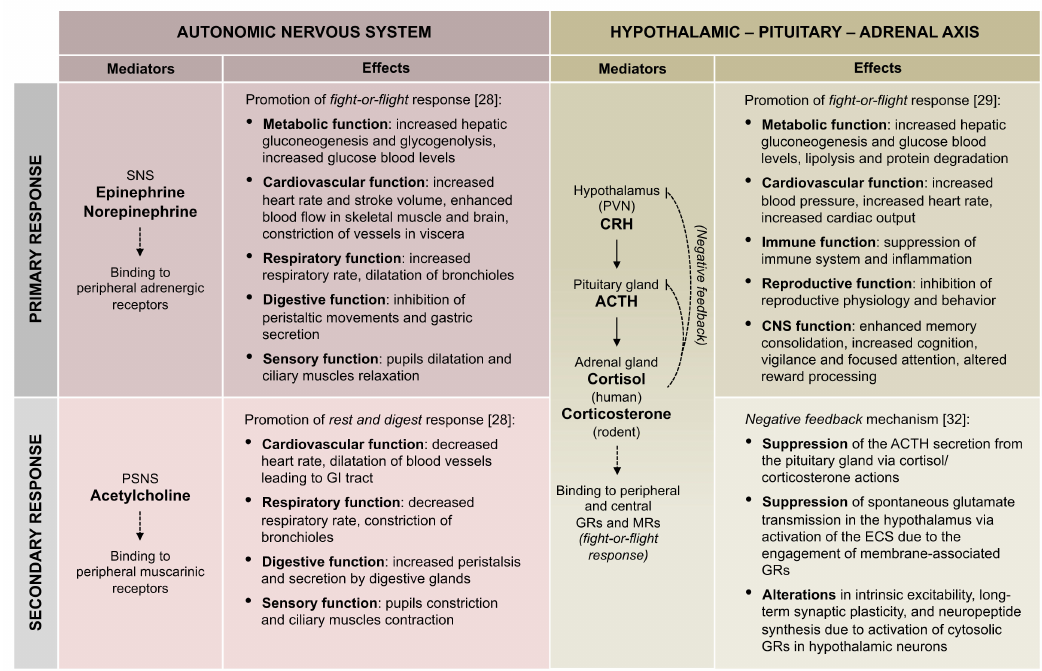
Figure 1. Primary and secondary autonomic nervous system (ANS) and the hypothalamus- pituitary-adrenal (HPA) axis response to stress. In the table, the molecular mediators and the main e ff ects of primary and secondary responses to stress of ANS and HPA axis are reported. In both systems, the primary response promotes fight-or-flight reaction to properly face the perceived stress. Conversely, di ff erent secondary response mechanisms are adopted: ANS actively promotes rest and digest response through the activation of PSNS, whereas HPA axis secondary response consists of negative feedback mechanisms guaranteeing the recovery of resting conditions-inherent axis responsivity. SNS (Sympathetic nervous system); PSNS (Parasympathetic nervous system); PVN (Paraventricular nucleus); CRH (Corticotropin releasing hormone); ACTH (Adrenocorticotropic hormone); GRs (Glucocorticoid receptors); MRs (Mineralocorticoid receptors); CNS (Central nervous system); ECS (Endocannabinoid